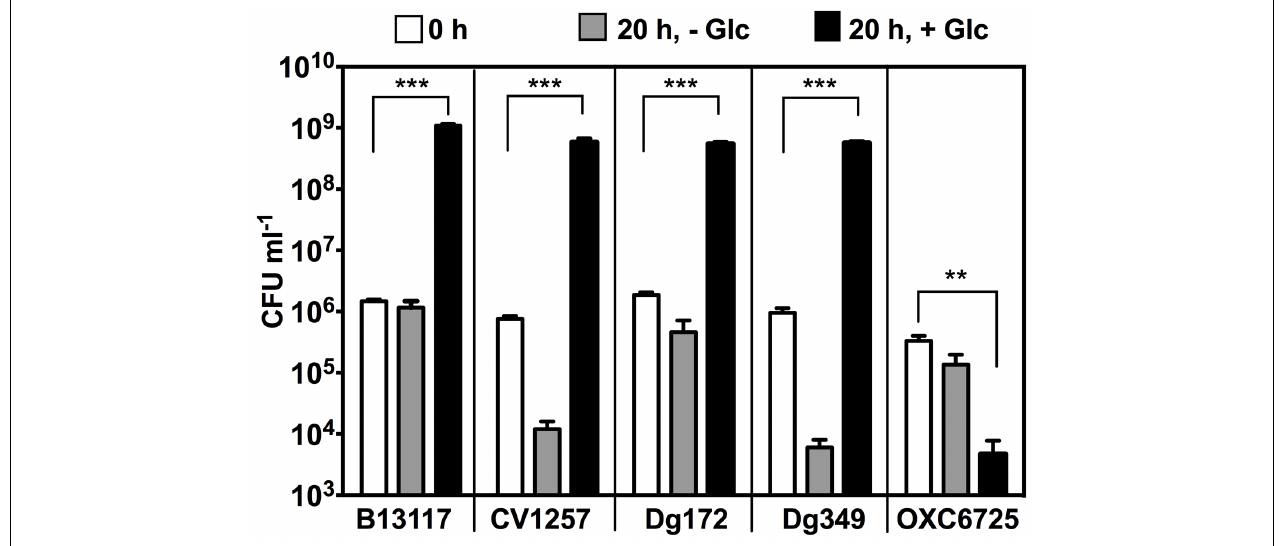
FIGURE 4 | Glucose stimulates growth of ED-positive but not ED-negative C. coli isolates. Four ED-positive C. coli isolates (B13117, CV1257, Dg172, and Dg349) and an ED-negative control C. coli strain (OXC6725) were inoculated into modified MCLMAN minimal media either without or with glucose supplementation. Cultures were incubated for 20 h at 37 ◦ C under microaerobic conditions and viable cell numbers measured by plate counts. White bars, colony forming units (CFU) ml − 1 of inoculum at time 0. Light gray bars, final CFU ml − 1 in modified MCLMAN without glucose. Black bars, final CFU ml − 1 in modified MCLMAN supplemented with 100 mM glucose. The bars show the mean and the error bars show the standard deviations of three independent cultures. Statistical significance is indicated by ( ∗∗ p < 0.01) or ( ∗∗∗ p < 0.001) as determined by Student’s t